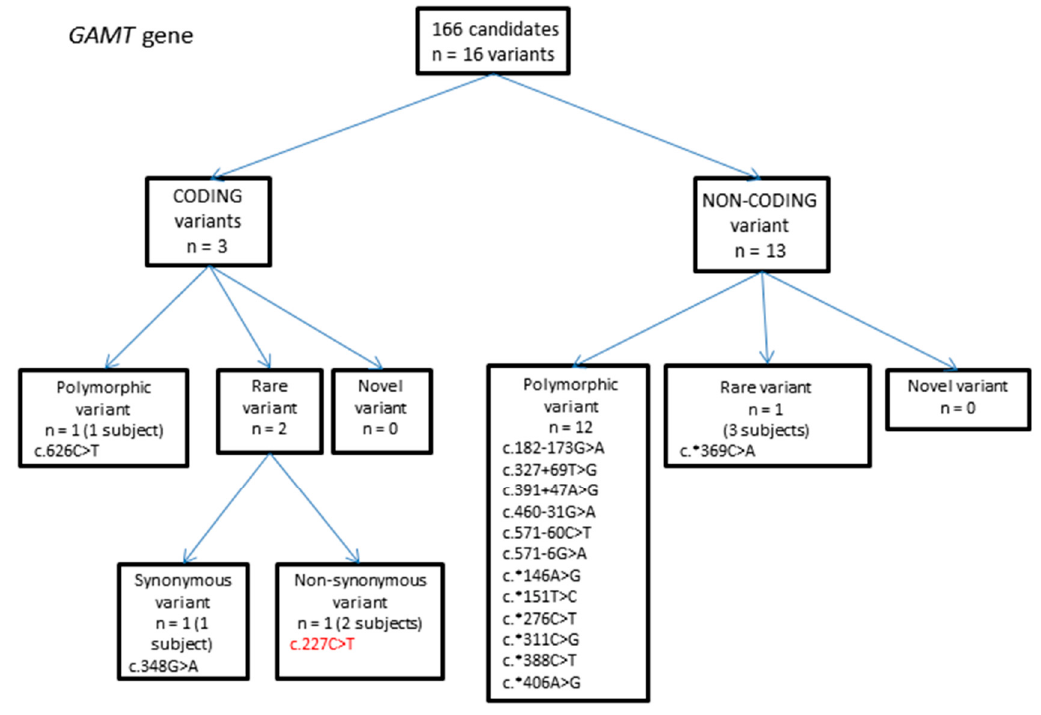
Figure 2. Flowchart summarizing variants identified in the guanidinoacetate methyltransferase ( GAMT ) gene.